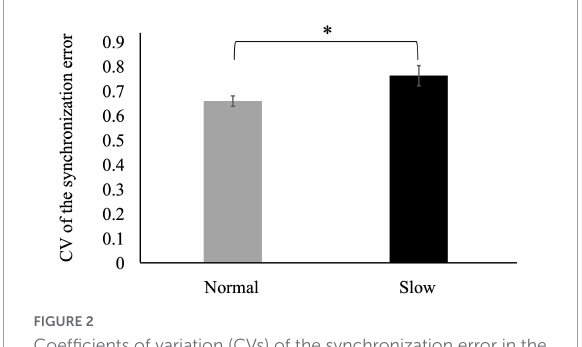
FIGURE2 Coefficients of variation (CVs) of the synchronization error in the slow tempo condition were larger than those in the normal tempo condition (* p < 0.05). Error bars represent the standard error.